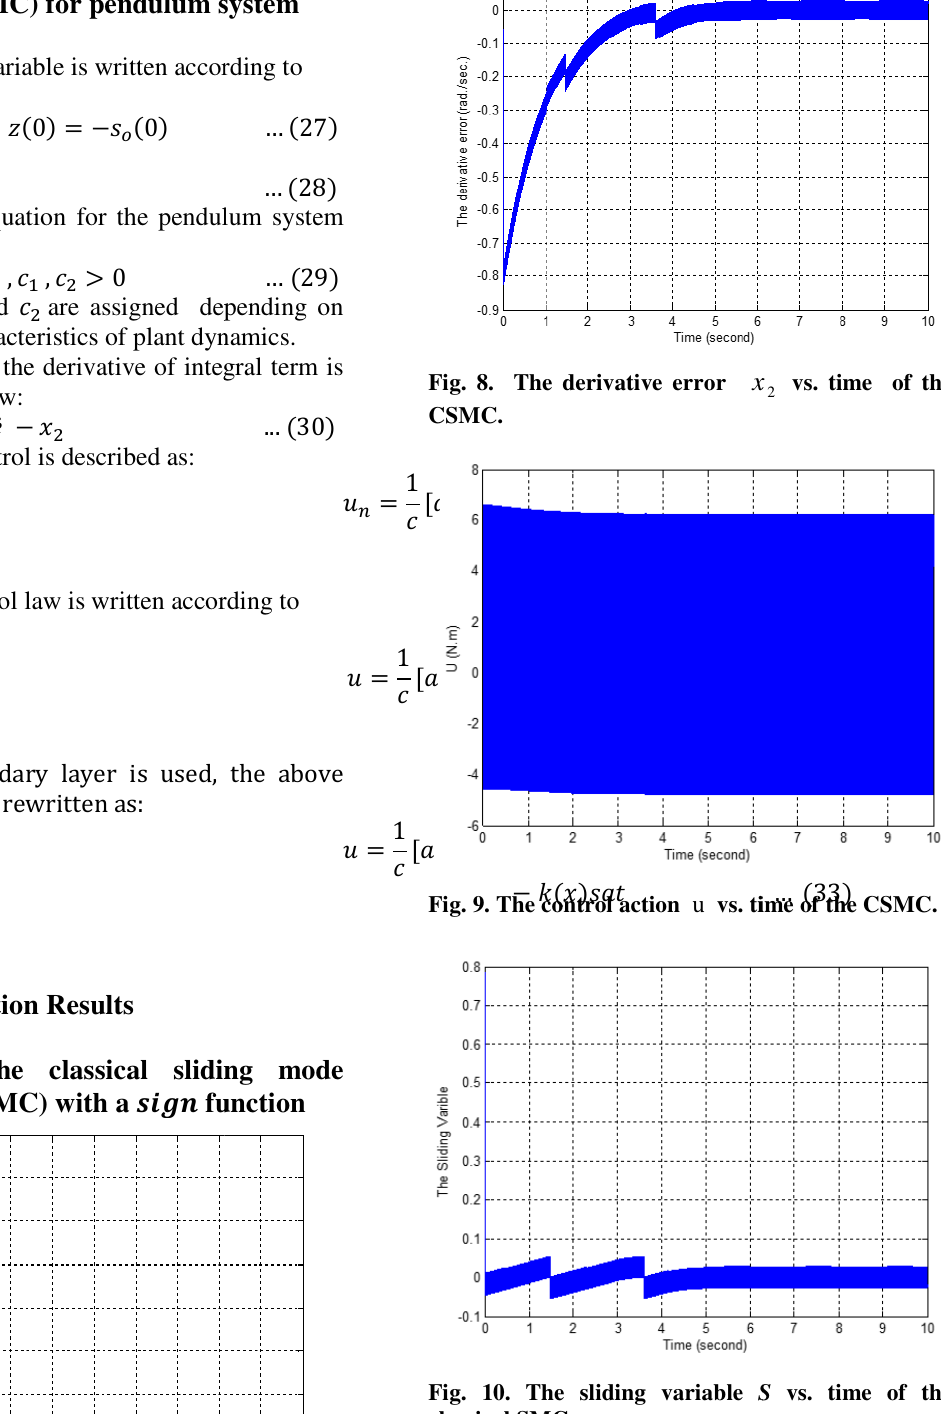
Fig. 10. The sliding variable S classical SMC